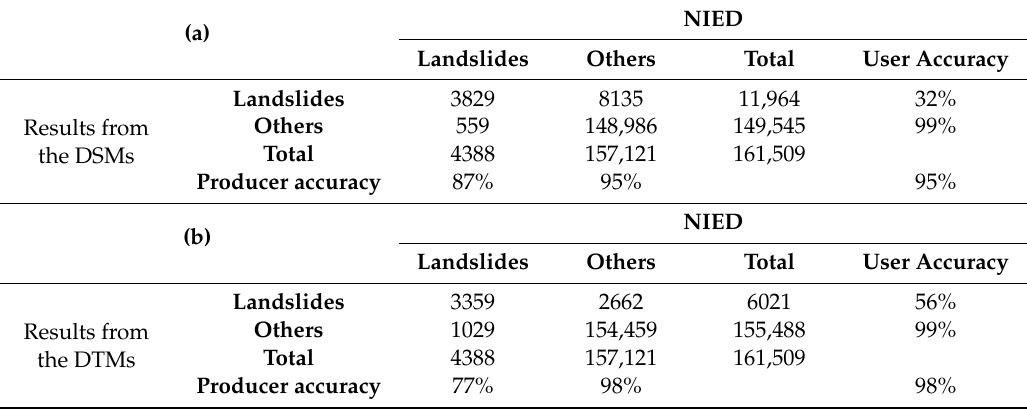
Figure 9. Comparison of the final extracted landslides and the regions traced by NIED in white lines: ( a ) Five regions extracted from the DSMs; ( b ) four regions extracted from DTMs. Table 1. Confusion matrix of the results extracted from the DSMs ( a ) and the DTMs ( b ).